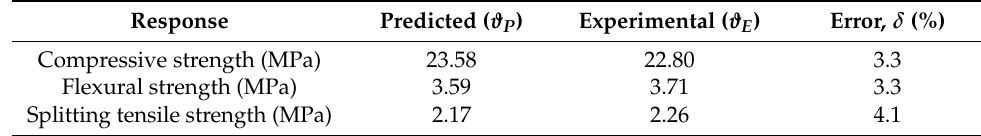
Table 7. Experimental